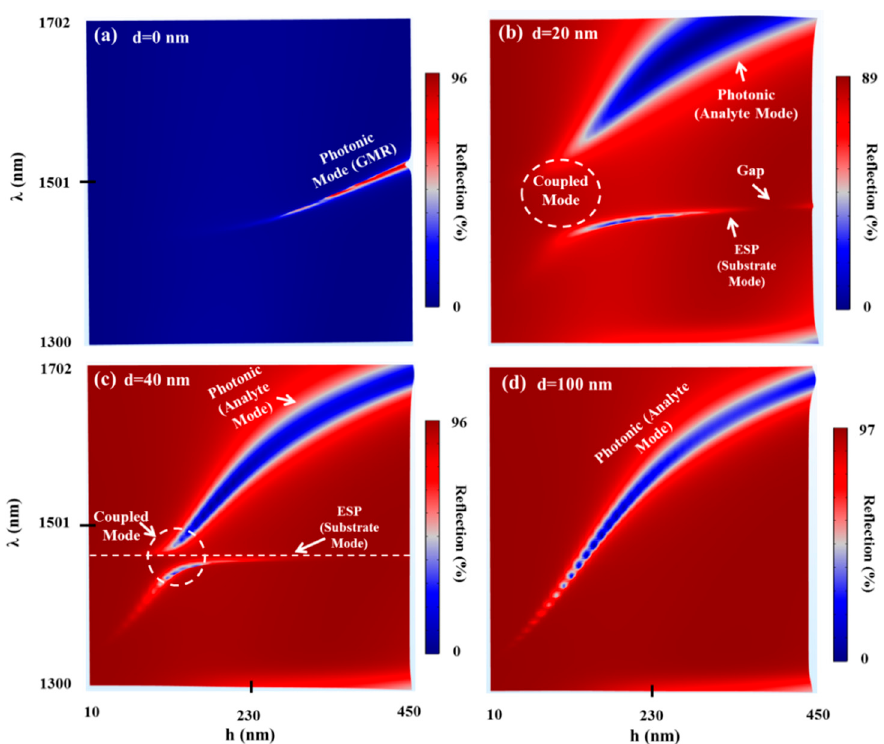
Figure 5. Reflection h– λ maps of the TDGTMF geometry for different values of d: ( a ) d = 0 nm, ( b ) d = 20 nm, ( c ) d = 40 nm, and ( d ) d = 100 nm. TM polarized light under normal incidence was used in the simulations of the Si 3 N 4 grating with Λ = 1000 nm and FF = 0.55. Water and SiO 2 were used for the superstrate (analyte) and substrate, respectively.